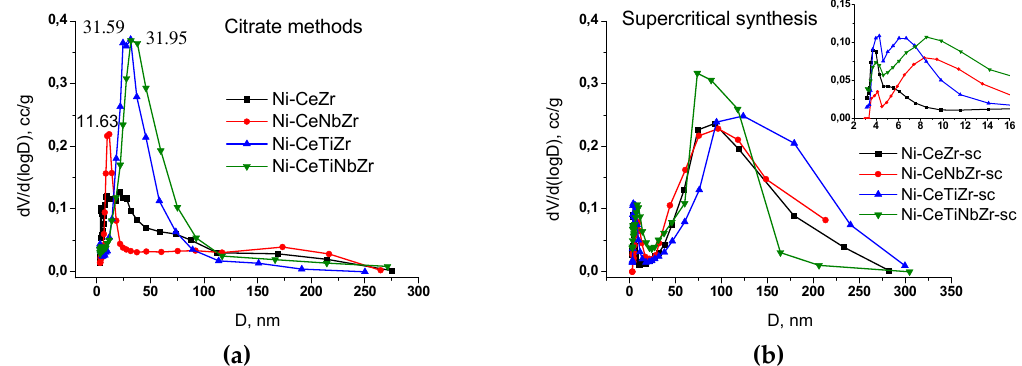
Figure 2. The pore size distribution for the catalysts obtained by the BJH method using desorption branch of the isotherm. Mixed oxides were prepared by the citrate methods ( a ) and by supercritical synthesis ( b ).